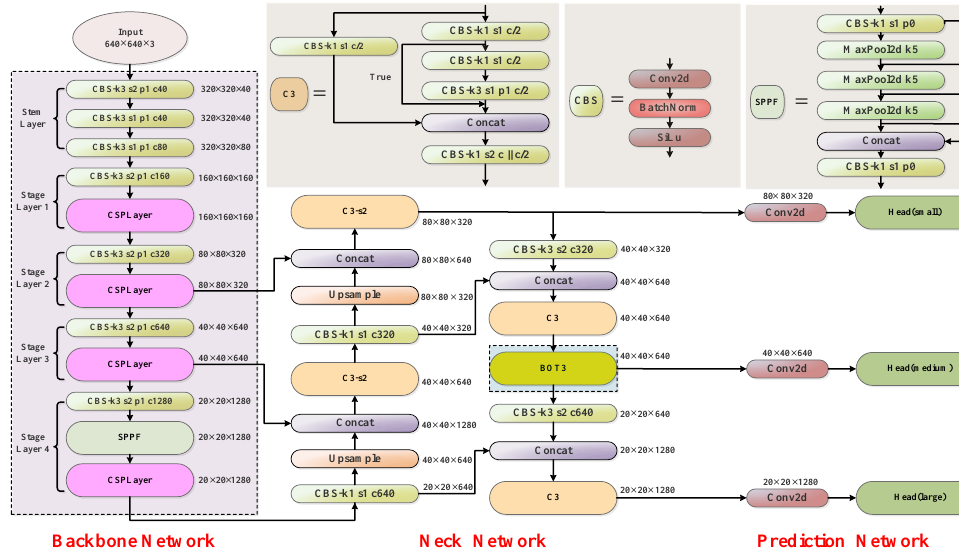
Figure 3. Improved YOLOv5 network framework.